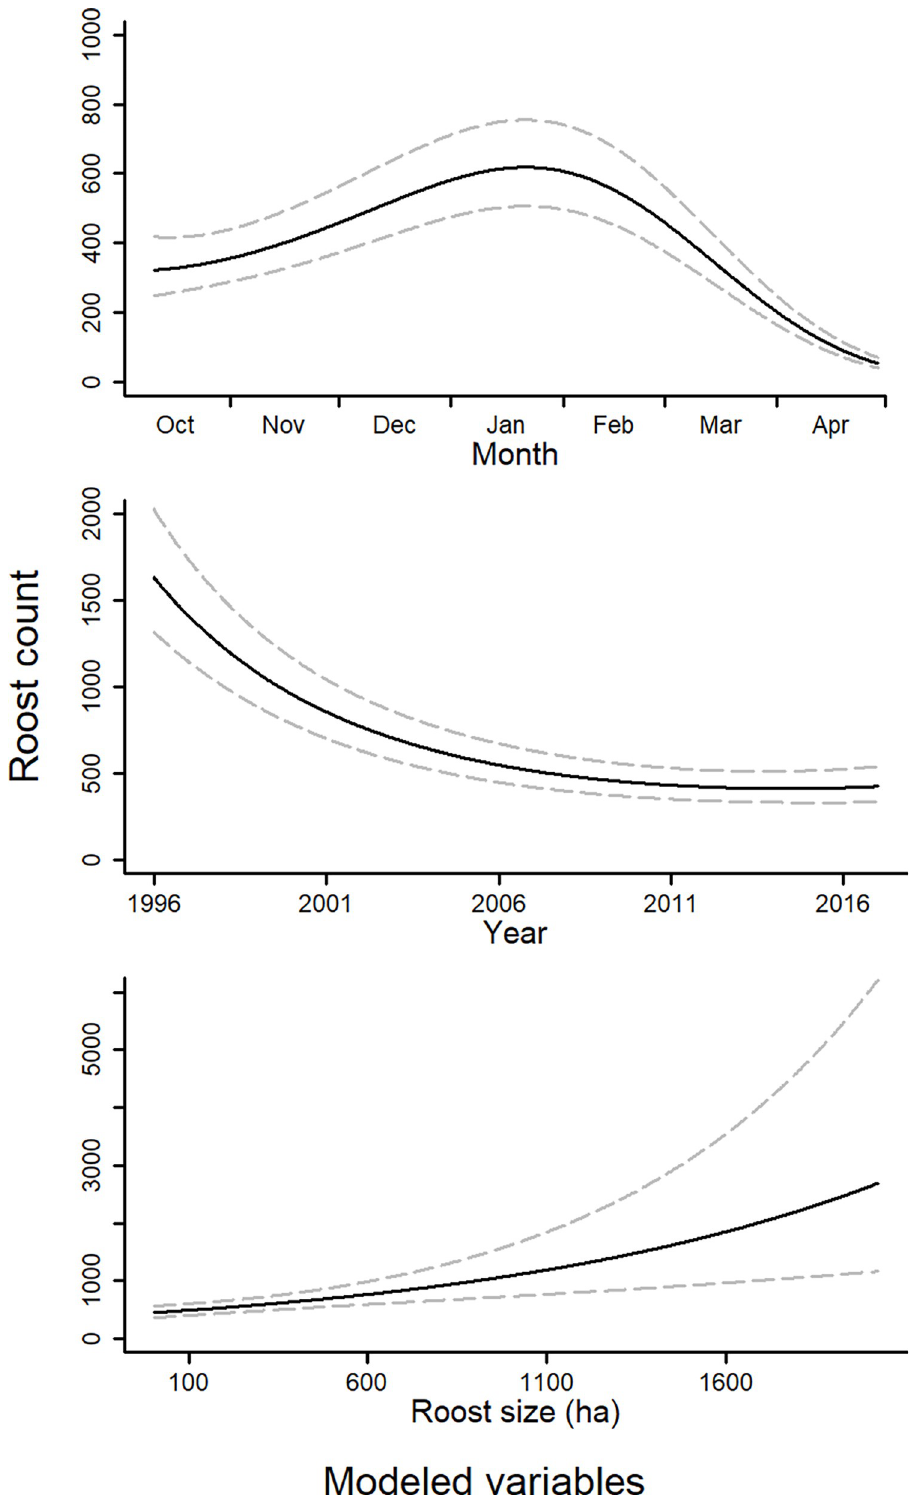
Fig 4. Average predicted abundance (+ 95% CI) of cormorants at roosting sites in the Mississippi Delta in relation to date, year, and the area of the occupied roost. Trend lines were created from model predictions made by allowing each variable of interest to vary over its range and holding all other variables at their mean.